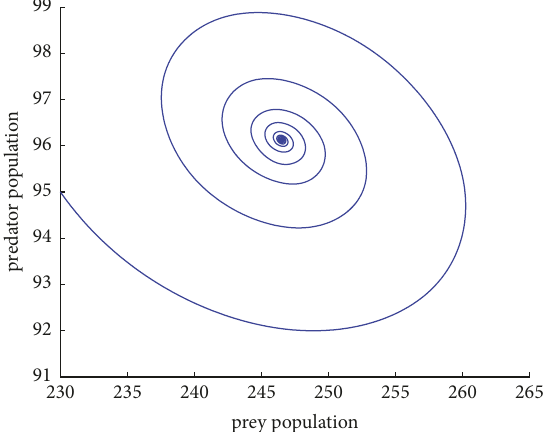
Figure 18: The phase portrait of delayed model (3) with the time delay 𝜏 1 = 𝜏 2 = 0.1 . The parameters are taken as 𝑥(0) = 230 , 𝑦(0) = 95 , 𝐴 = 0.01 , 𝑟 = 2.65 , 𝐾 = 900 , 𝑎 = 0.02 , 𝑐 = 0.215 , and 𝑚 = 1.06 ; 𝐸 = (𝑥 , 𝑦 ) is locally asymptotically stable, with no limit cycle. ∗ ∗ ∗